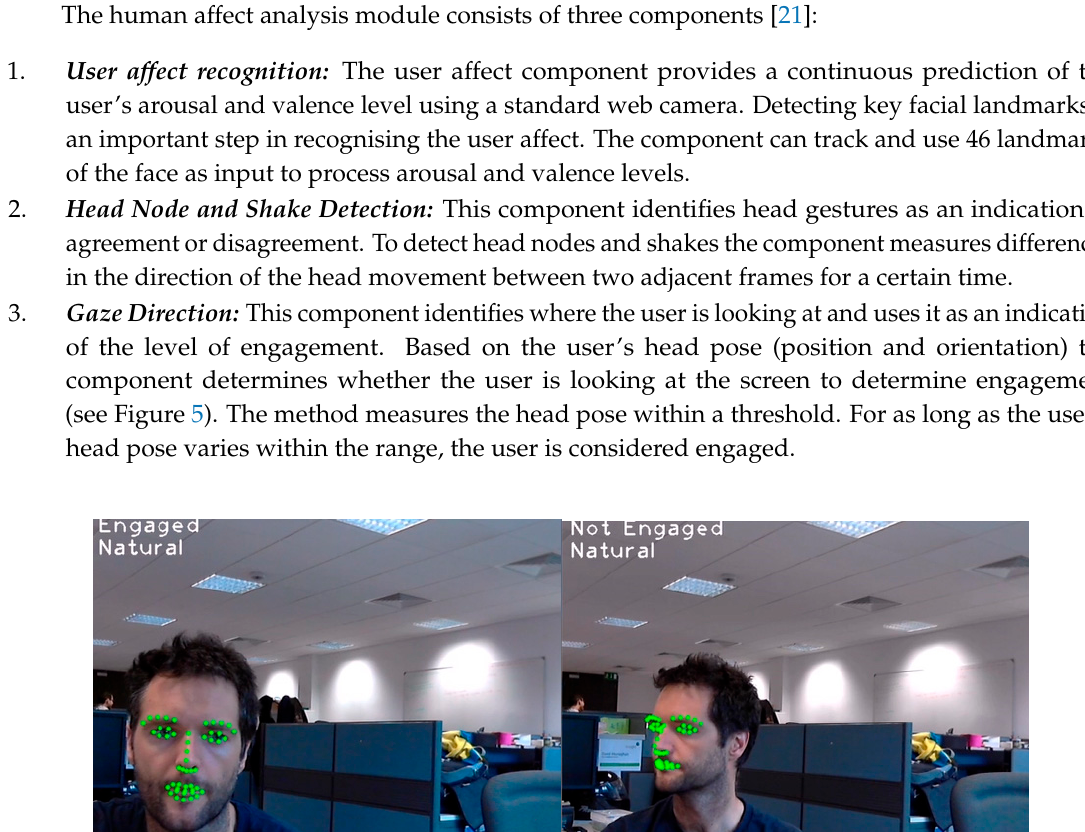
Figure 4. Level of engagement displayed on the GUI.